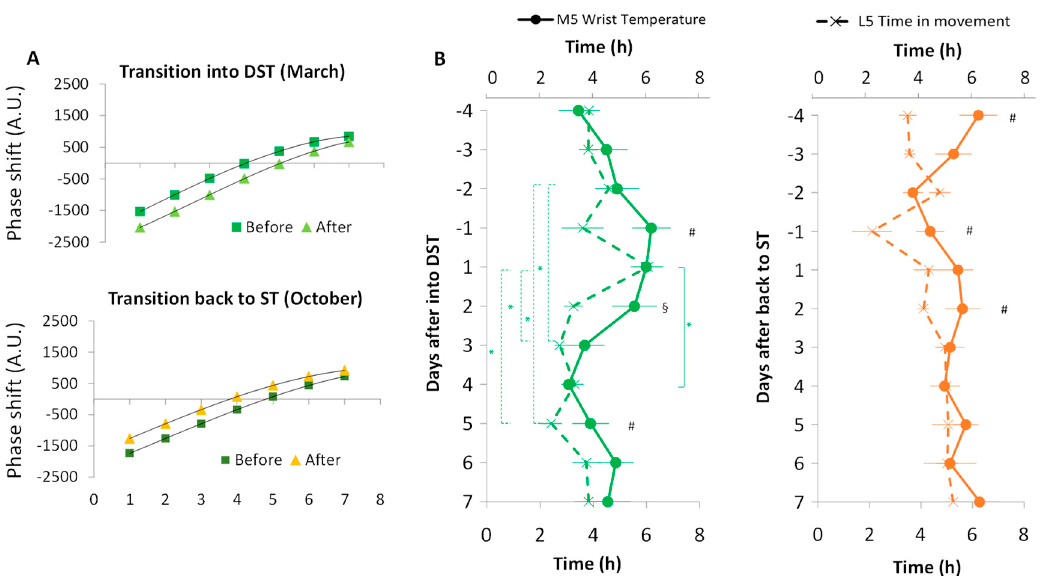
Figure 4. ( A ) Modeling of phase shifts according to the phase response curve [51] ( n = 8) to natural light before (square) and after (triangle) the transition to DST ( upper panel) and back to ST ( lower panel) by chronotype (MCTQ). See the Section 2 for details. ( B ) TM5 for WT ( n = 8; solid line) and TL5 for TiMo ( n = 8; dashed line) after transitions to DST ( left panel) and back to ST ( right panel). As a reference, the averages of TM5 for WT (circle) and TL5 for TiMo (cross) from the days before the transitions (4 days before DST and 6 days before ST) are included. Data are expressed as the mean ± SEM. * indicates p < 0.05 between different days (repeated measures ANOVA, Bonferroni post-hoc comparison). # indicates p < 0.05 between TL5 and TM5 each day (paired T-test). § indicates p = 0.05 between TL5 and TM5 each day (paired T-test).